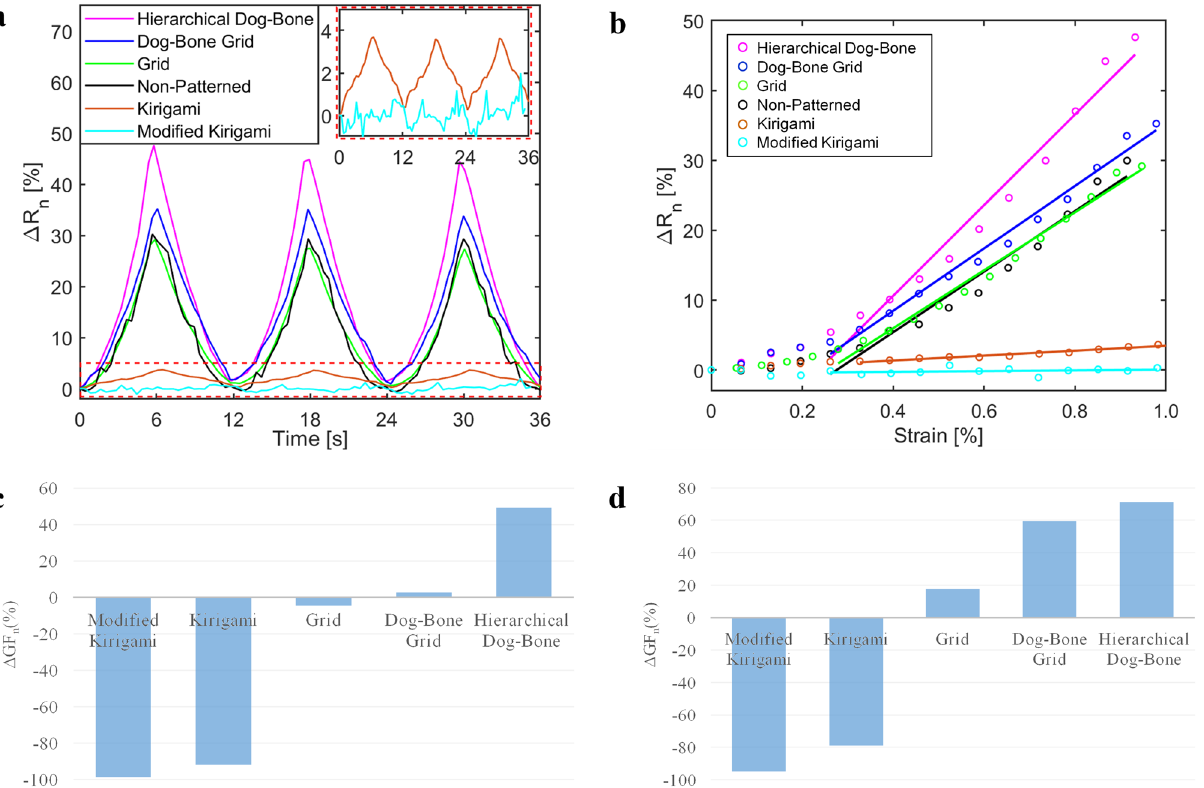
Figure 3. Electromechanical responses of different patterned nanocomposite thin films. ( a ) Representative ΔR n time histories of the different patterned GNS-EC specimens subjected to the same tensile cyclic strain pattern are overlaid. The inset shows the electromechanical response of the Kirgimi and Modified Kirigami specimens. ( b ) The ΔR n of the GNS-EC specimens are plotted as functions of the increasingly applied strain during one loading cycle. Linear least-squares regression lines are fitted to data where strain ≥ 0.3%. The ΔGF n of ( c ) GNS-EC and ( d ) CNT-latex nanocomposite thin films obtained by different topological designs as compared to the Non-patterned control sets,